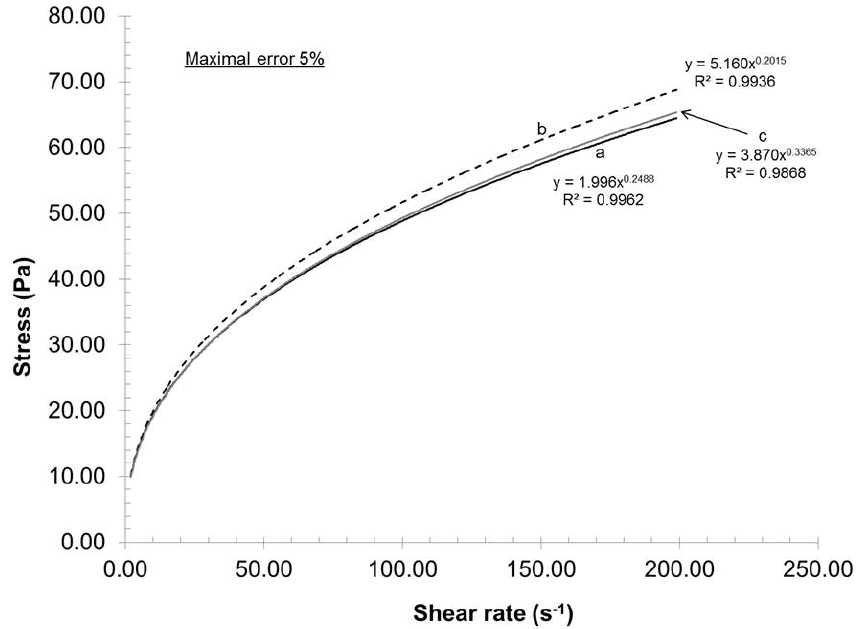
Figure 1. Experimental error